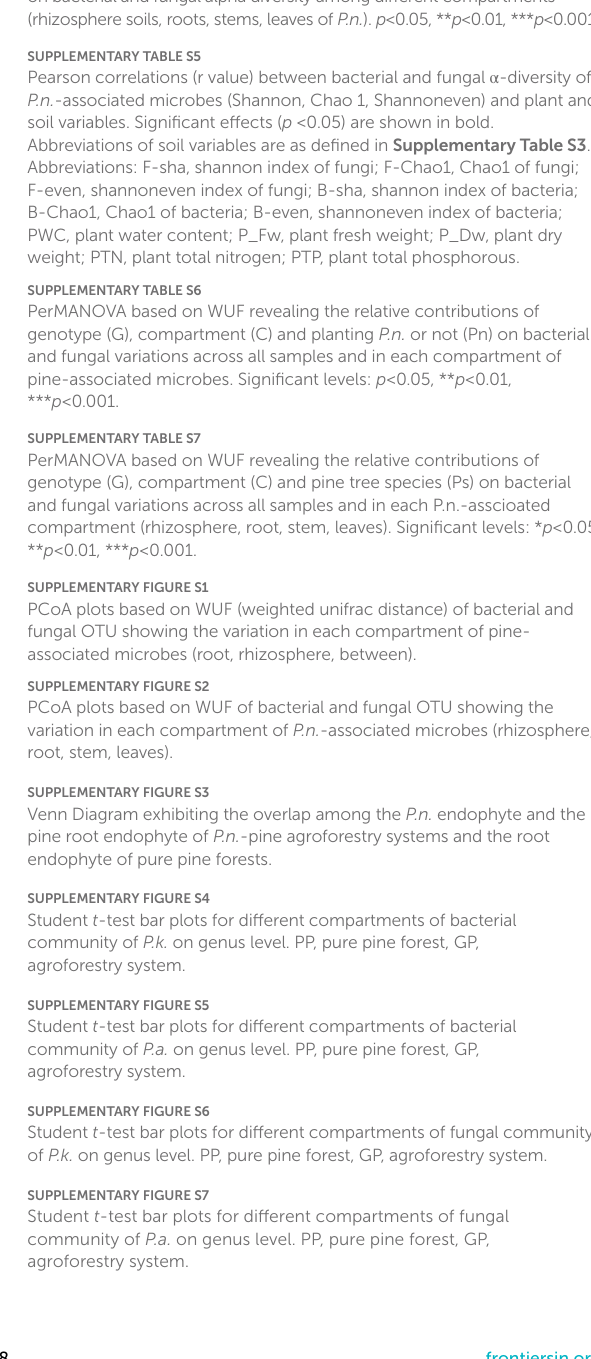
compartments (bulk and rhizosphere soils, and root of pine trees). Significant effects ( p <0.05) are shown in bold. p < 0.05, ** p < 0.01,